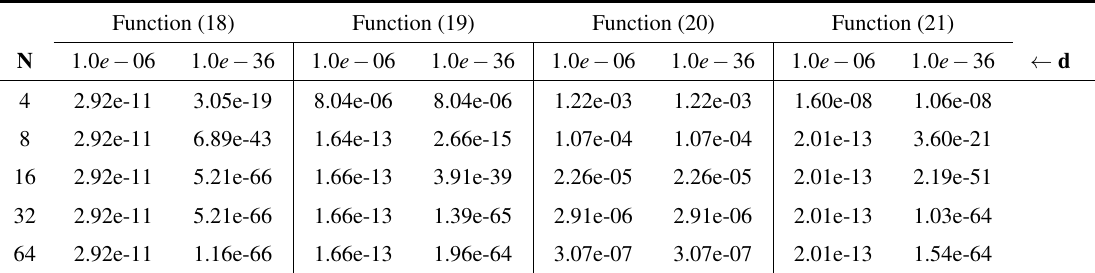
Table 2 C || e r || L